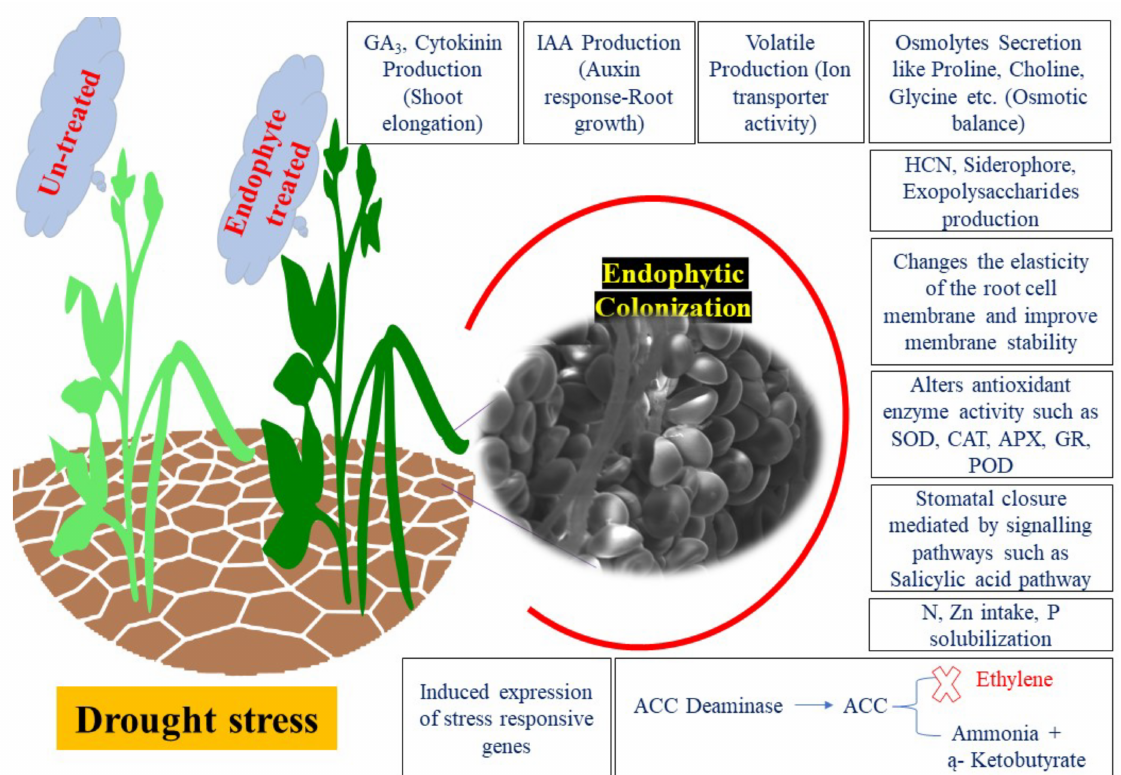
Figure 2. Endophyte-mediated drought tolerance in plants. As part of a plant–endophyte